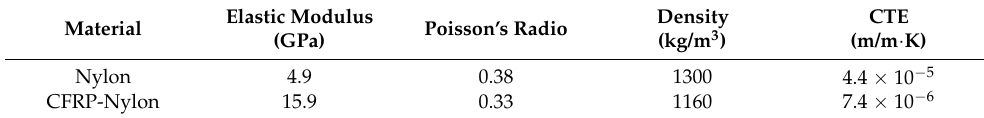
Figure 4. Lattice structure constructed with the circular array method. (Note: the triangle type does not have the centered cell of N = 0.).